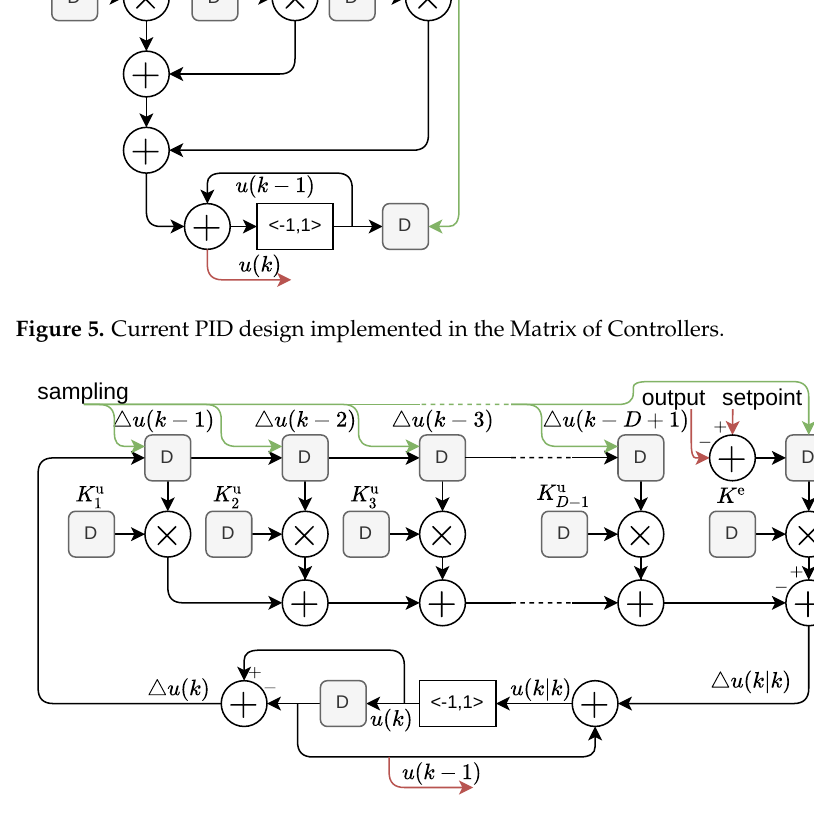
Figure 6. Design of Fast Dynamic Matrix Controller algorithm for FPGA